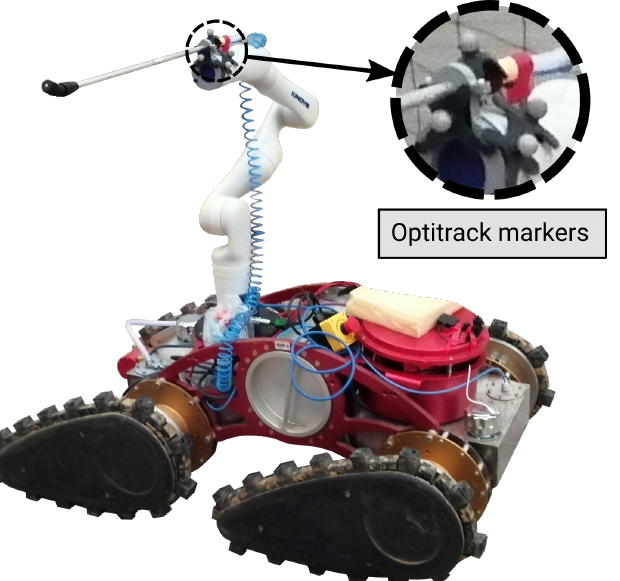
Figure 13. For the second experiment, reference tracking is externally validated using Optitrack cameras to measure the position of the spray frame in the real world. Optitrack markers are attached to the end-effector of the robot arm.